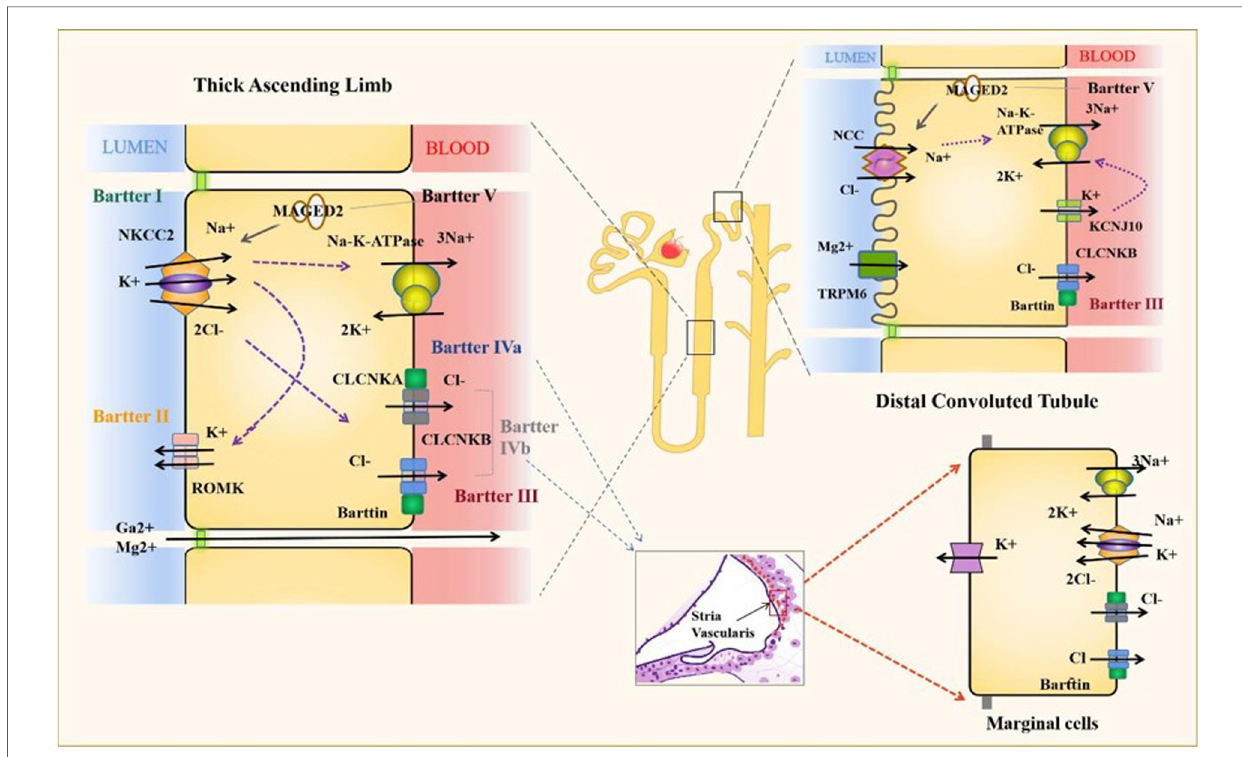
FIGURE 1 Proteins and channels implicated in the pathogenesis of bartter syndrome. The electrolyte transport of the most important channels for the diseases is represented. Bartter Syndrome IV also shows important ion channels at the stria vascularis. NKCC2, Solute carrier family 12 members 1; ROMK, ATP- sensitive inward recti fi er potassium channel 1; CLCNKA, Chloride channel protein ClC-Ka; CLCNKB, Chloride channel protein ClC-Kb; NCC, Solute carrier family 12 members 3; MAGED2, Melanoma-associated antigen D2 and TRPM6,: Transient receptor potential cation channel subfamily M member